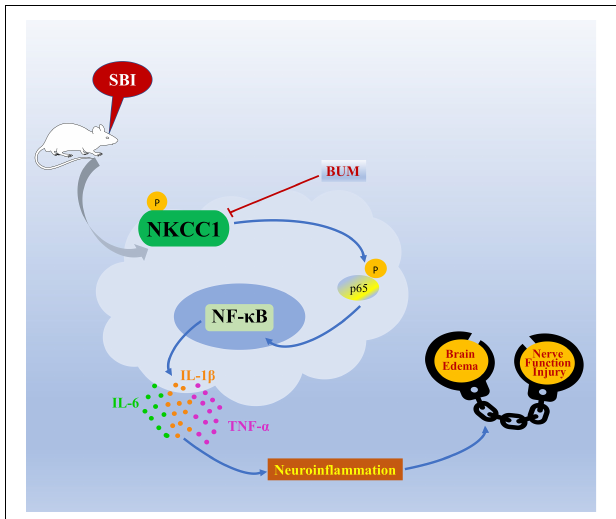
FIGURE 8 | A model illustrating the possible mechanisms by which NKCC1 influences SBI by phosphorylation of NF- κ B. After SBI, microglia cells are activated, p-NKCC1 expression rapidly increases, and NF- κ B in the nucleus is phosphorylated. The increase in p-NF- κ B expression triggers the release of IL-6, IL-1 β , and TNF- α inflammatory factors, which leads to neuroinflammation, damages the BBB, ultimately leading to brain edema and nerve function